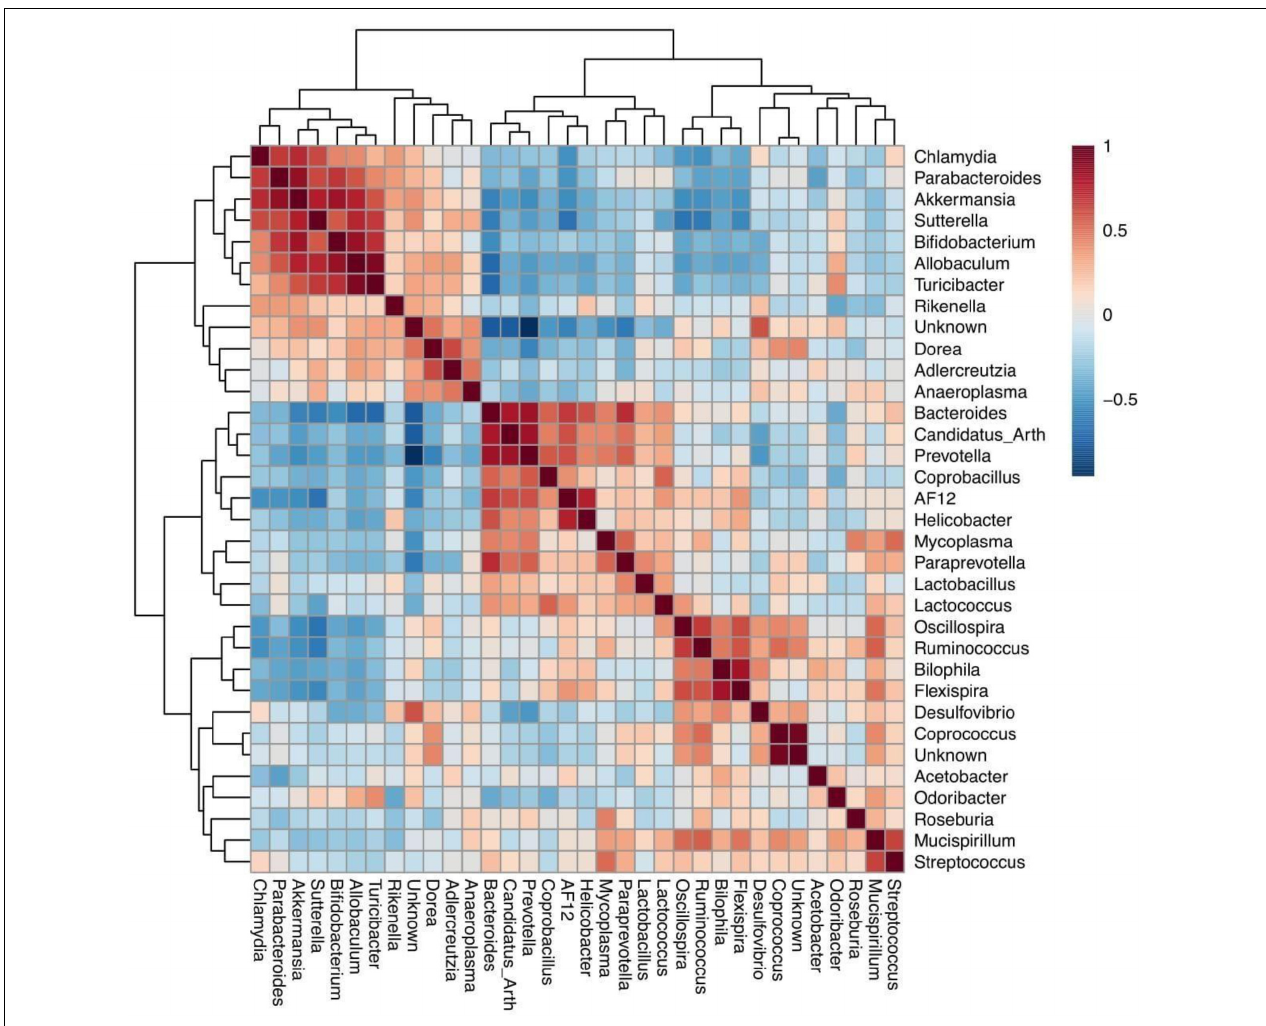
FIGURE 2 | Spearman rank correlation for bacterial genera identified on the fmr1 KO2 mouse gut microbiome. Red squares indicate a positive correlation, respectively (as is shown in the colored scale).